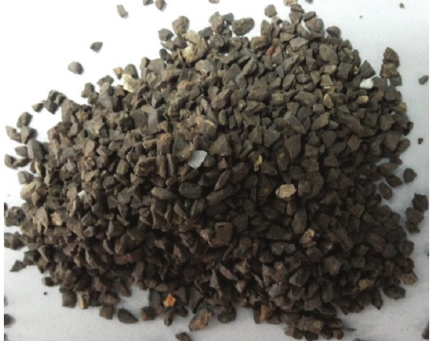
Figure 5: Crushed OPS aggregates with size of 1.18mm to 5